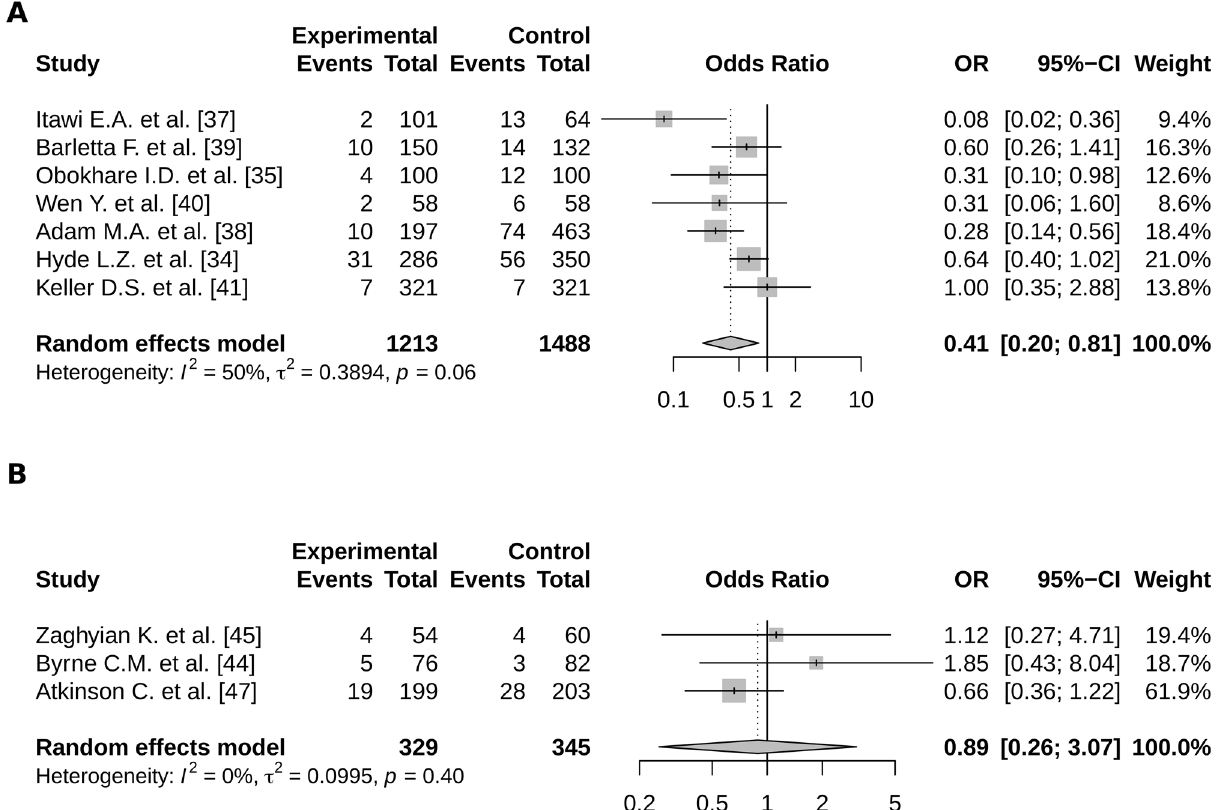
Figure 3. Meta-analysis of the risk of POI according to a treatment by ( A ) alvimopan and ( B ) chewing gum; (R software, 3.6.3, https:// www.R- proje ct.